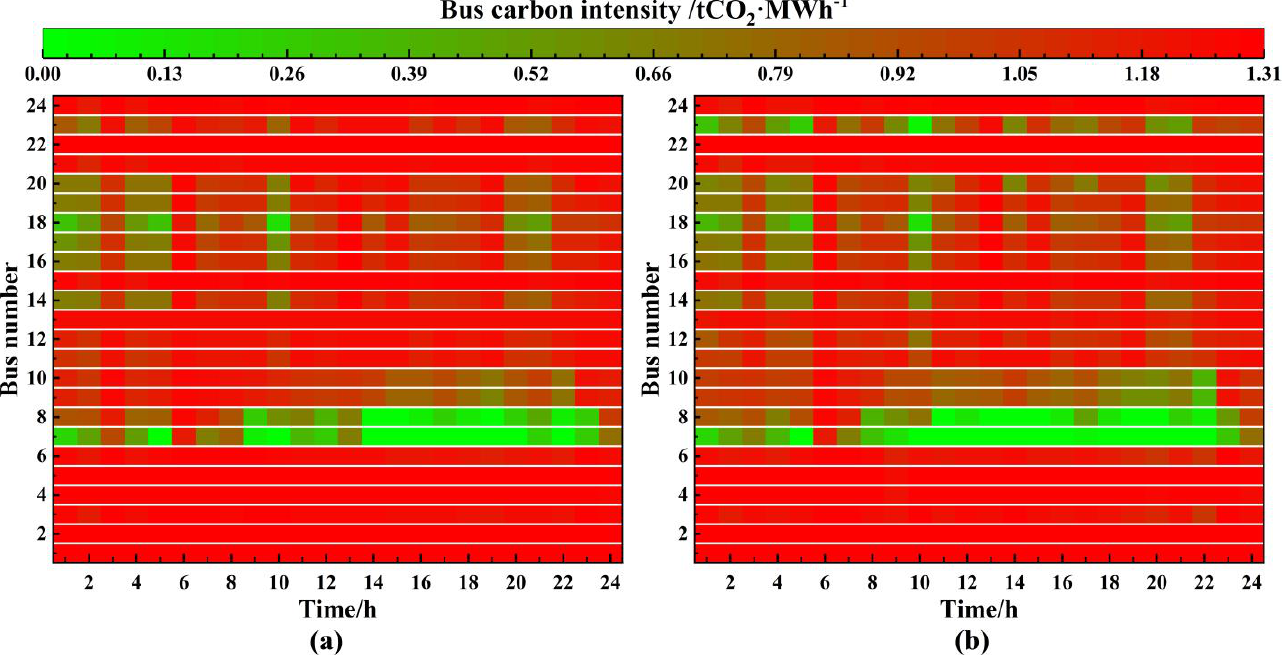
Figure 9. ( a ) Expectation of bus carbon intensity in Case 2; ( b ) expectation of bus carbon intensity in Case